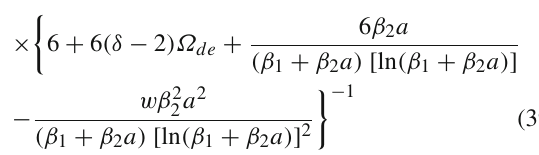
Fig. 8 Plot of deceleration parameter of of interacting THDE model versus redshift z for β 1 = 7 . 1, β 2 = 2 . 15, w = 1000, Ω 0 u = 0 .